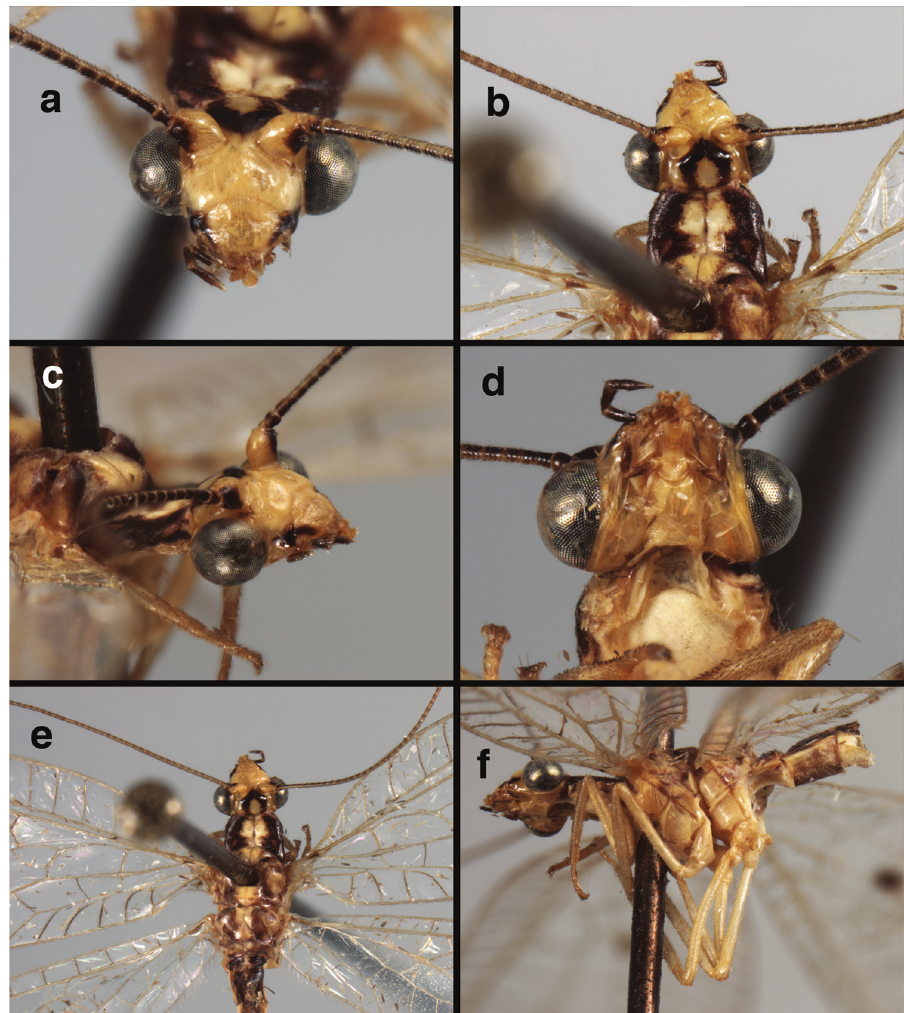
Figure 31. Ungla diazi Sosa: External features, ( a ) head, frontal ( b ) head, prothorax, dorsal ( c ) head, frontolateral ( d ) head, ventral ( e ) head, thorax, dorsal ( f ) head, thorax, ventrolateral (all: Bolivia, Cocha- bamba, male,